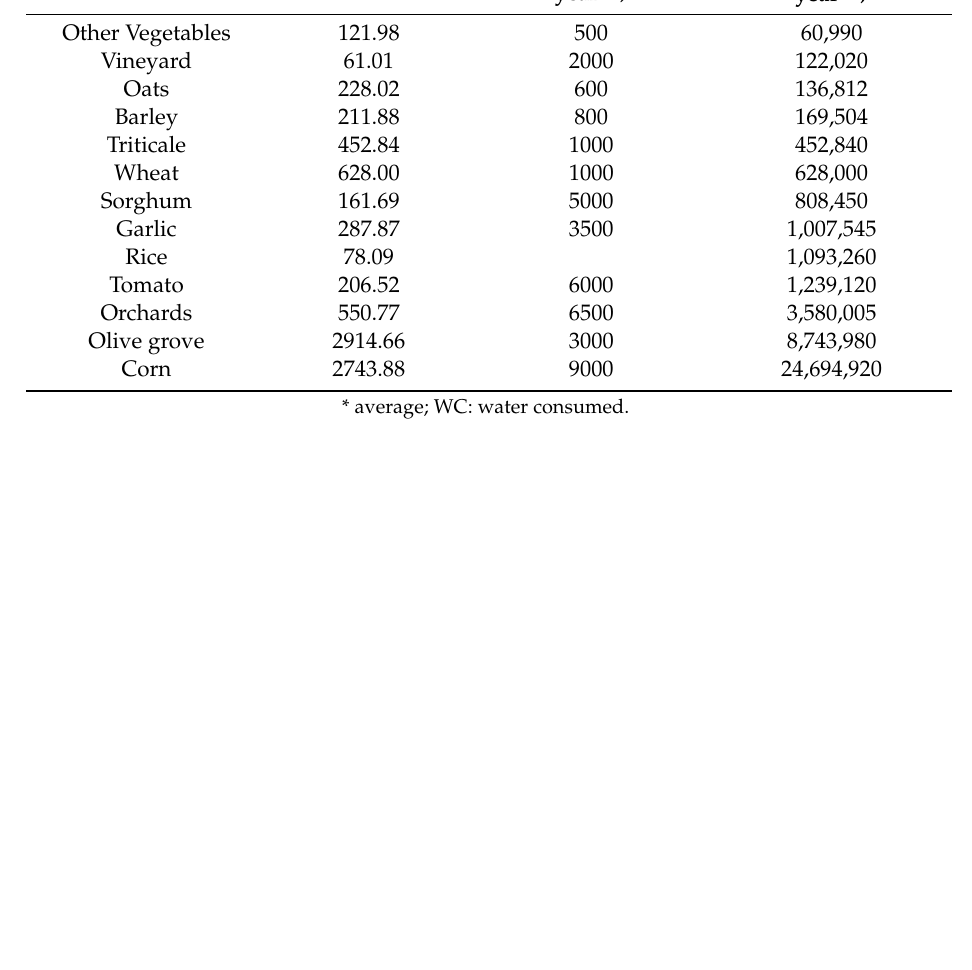
Table 3. Average water consumption of the main irrigated crops in the Caia River basin.